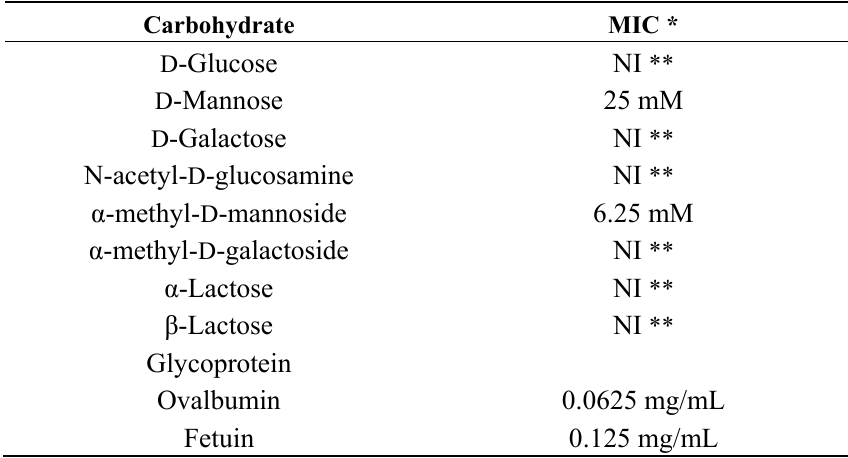
Table 1. Inhibitory effect of saccharides and glycoproteins on the hemagglutinating activity of Dioclea lasiophylla lectin.